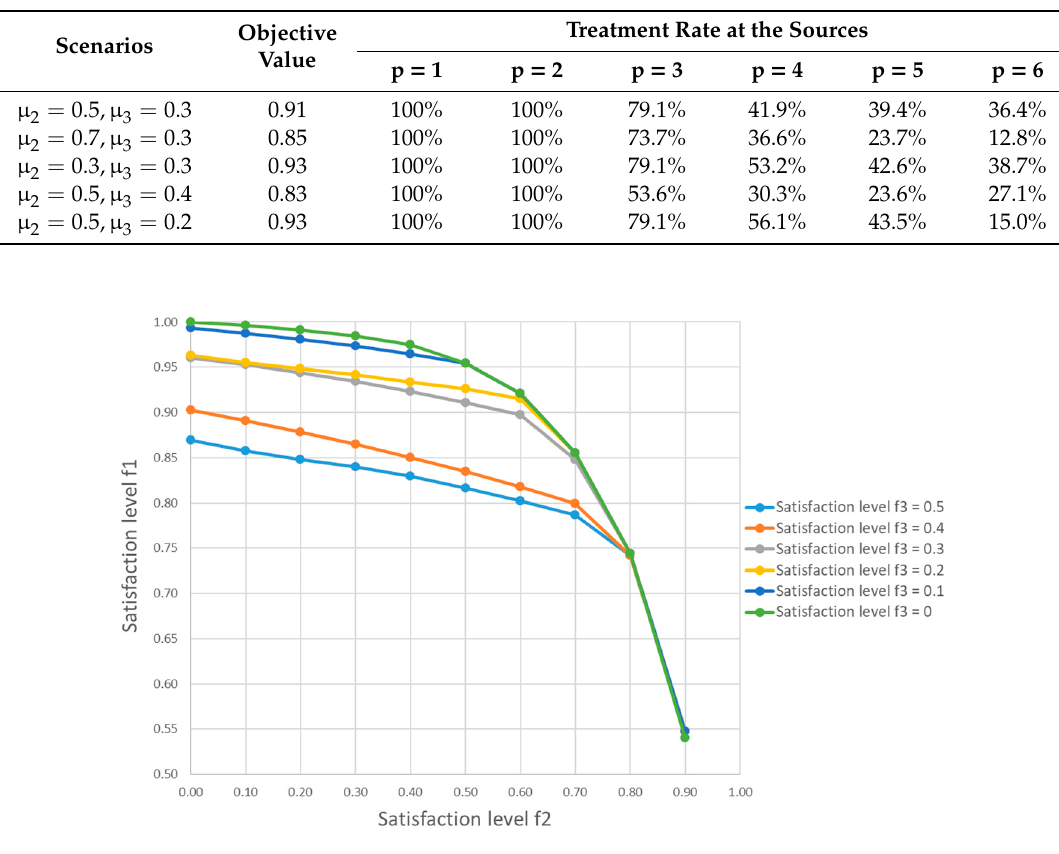
Figure 4. Pareto optimal solutions.